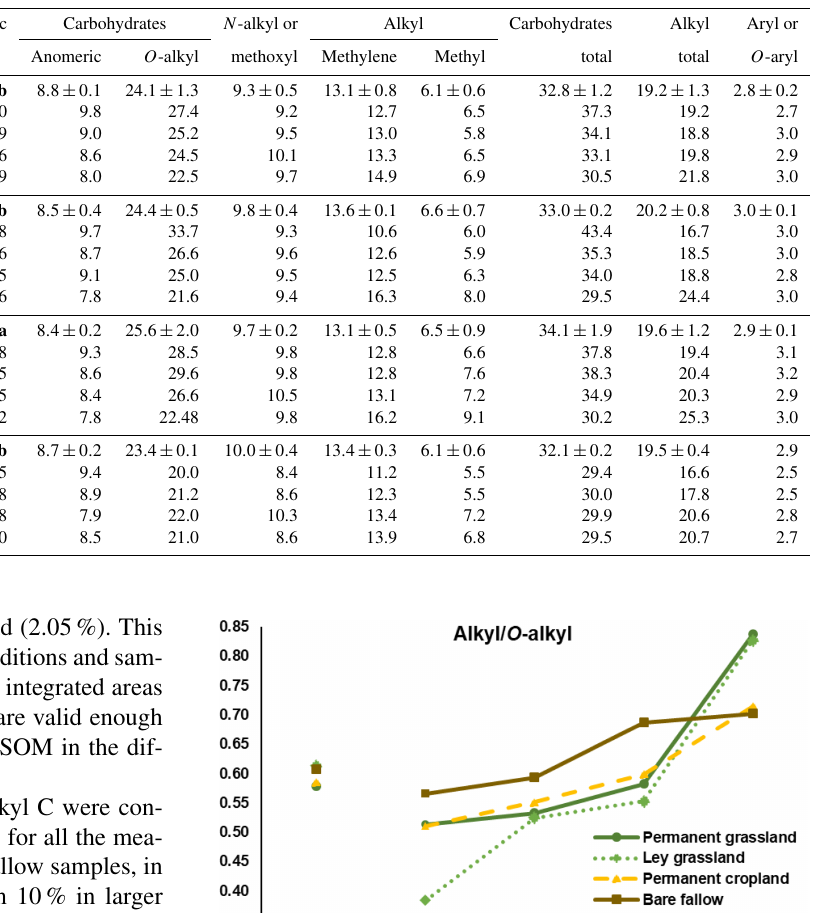
Table 3. Integration values (expressed as a percent of the total spectral area) and signal-to-area ratios of the main regions of 13 C NMR spectra from soils under contrasting agricultural management with ( ± ) standard deviations. Significant differences between treatments ( P < 0 . 05) for field replicates of bulk soil samples ( n = 3), according to the Kruskal–Wallis test, are indicated with different bold letters.